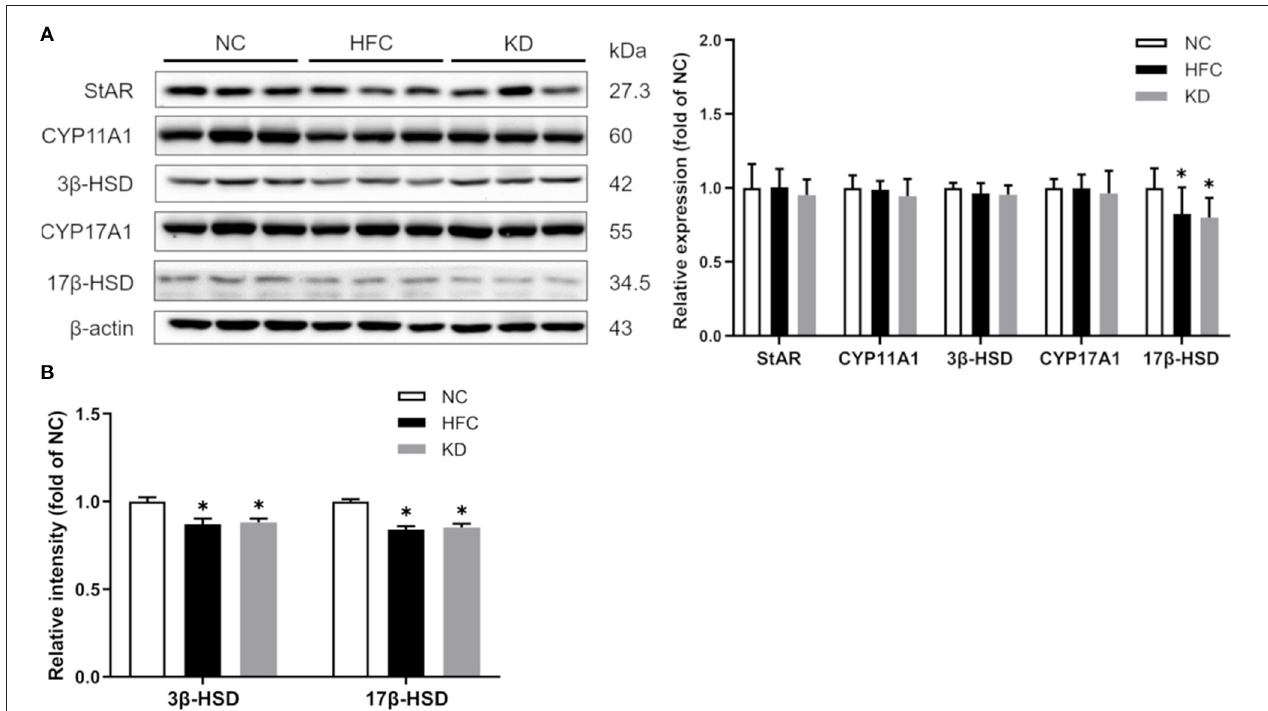
FIGURE 5 | Effects of a high-fat and high-cholesterol diet and a ketogenic diet on (A) testosterone biosynthesis regulators (StAR, CYP11A1, 3 β -HSD, CYP17A1, and 17 β -HSD) in male mice. Protein expressions in each group were measured using western blot analysis, and β -actin was used for normalization. (B) Activities of hydroxysteroid dehydrogenases (HSDs) were estimated using Elisa kits. Data are expressed as the mean ± SD. * p < 0.05, compared with the NC group; # p < 0.05, compared with the HFC group. NC, normal diet; HFC, high-fat and high-cholesterol diet; KD, HFC diet changed to MCT-based ketogenic diet.